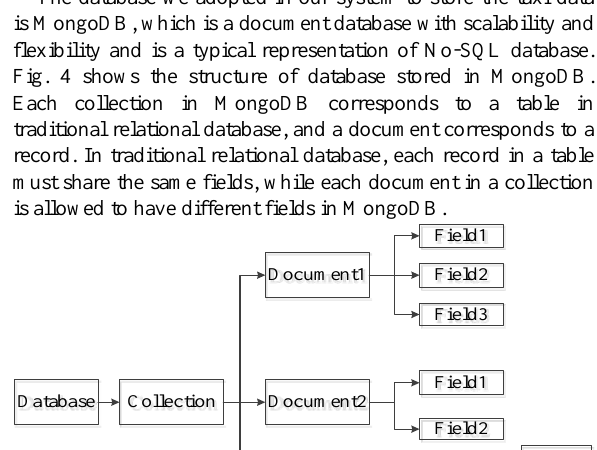
Figure 1. The procedure to remove drift data.